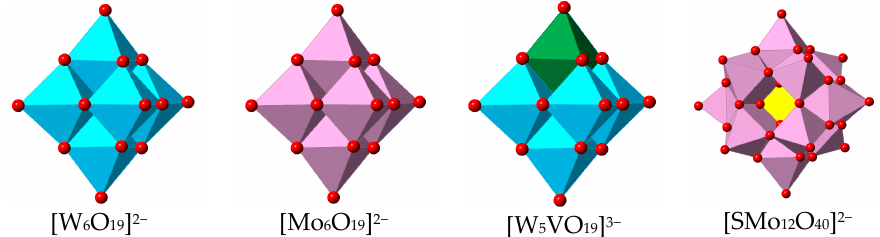
Figure 2. Structural units of the different polyoxometalates (POMs) used for anion exchange studies.